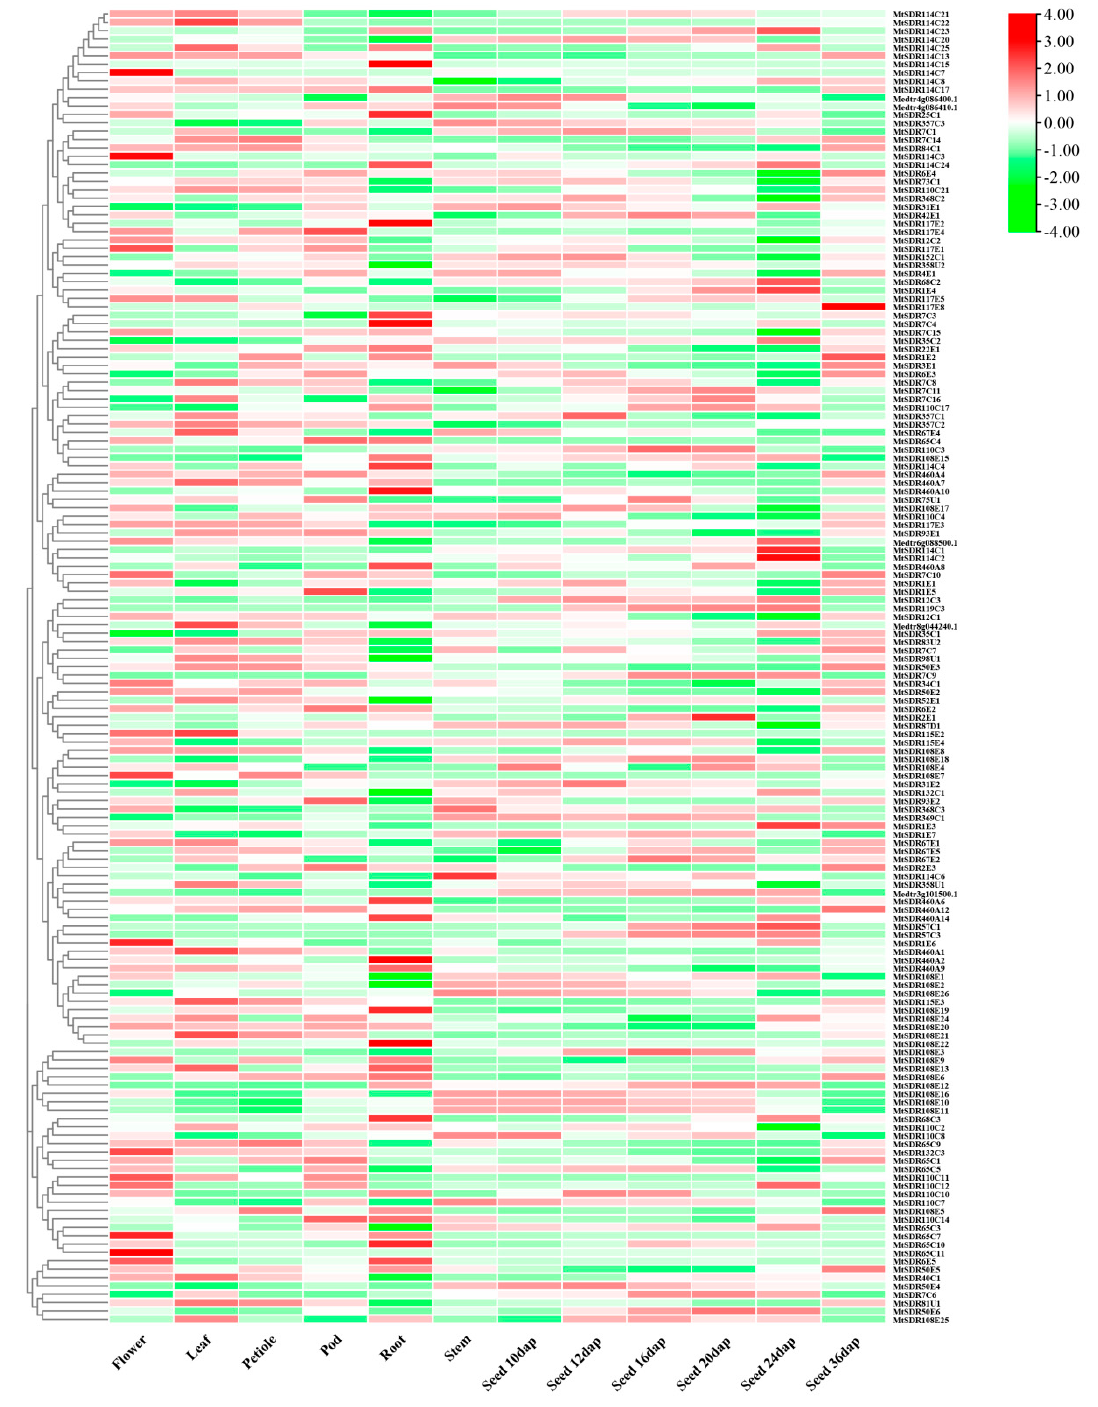
Figure 5. Heat map of MtSDRs in different organs. The expression data of MtSDRs in flowers, leaves, petioles, flowers, roots, stems, and seeds were collected from M. truncatula Gene Expression Atlas (MtGEA, https://mtgea.noble.org/v3/, accessed on 5 April 2021). The relative expression of heat map was characterized by log 2 transformed.